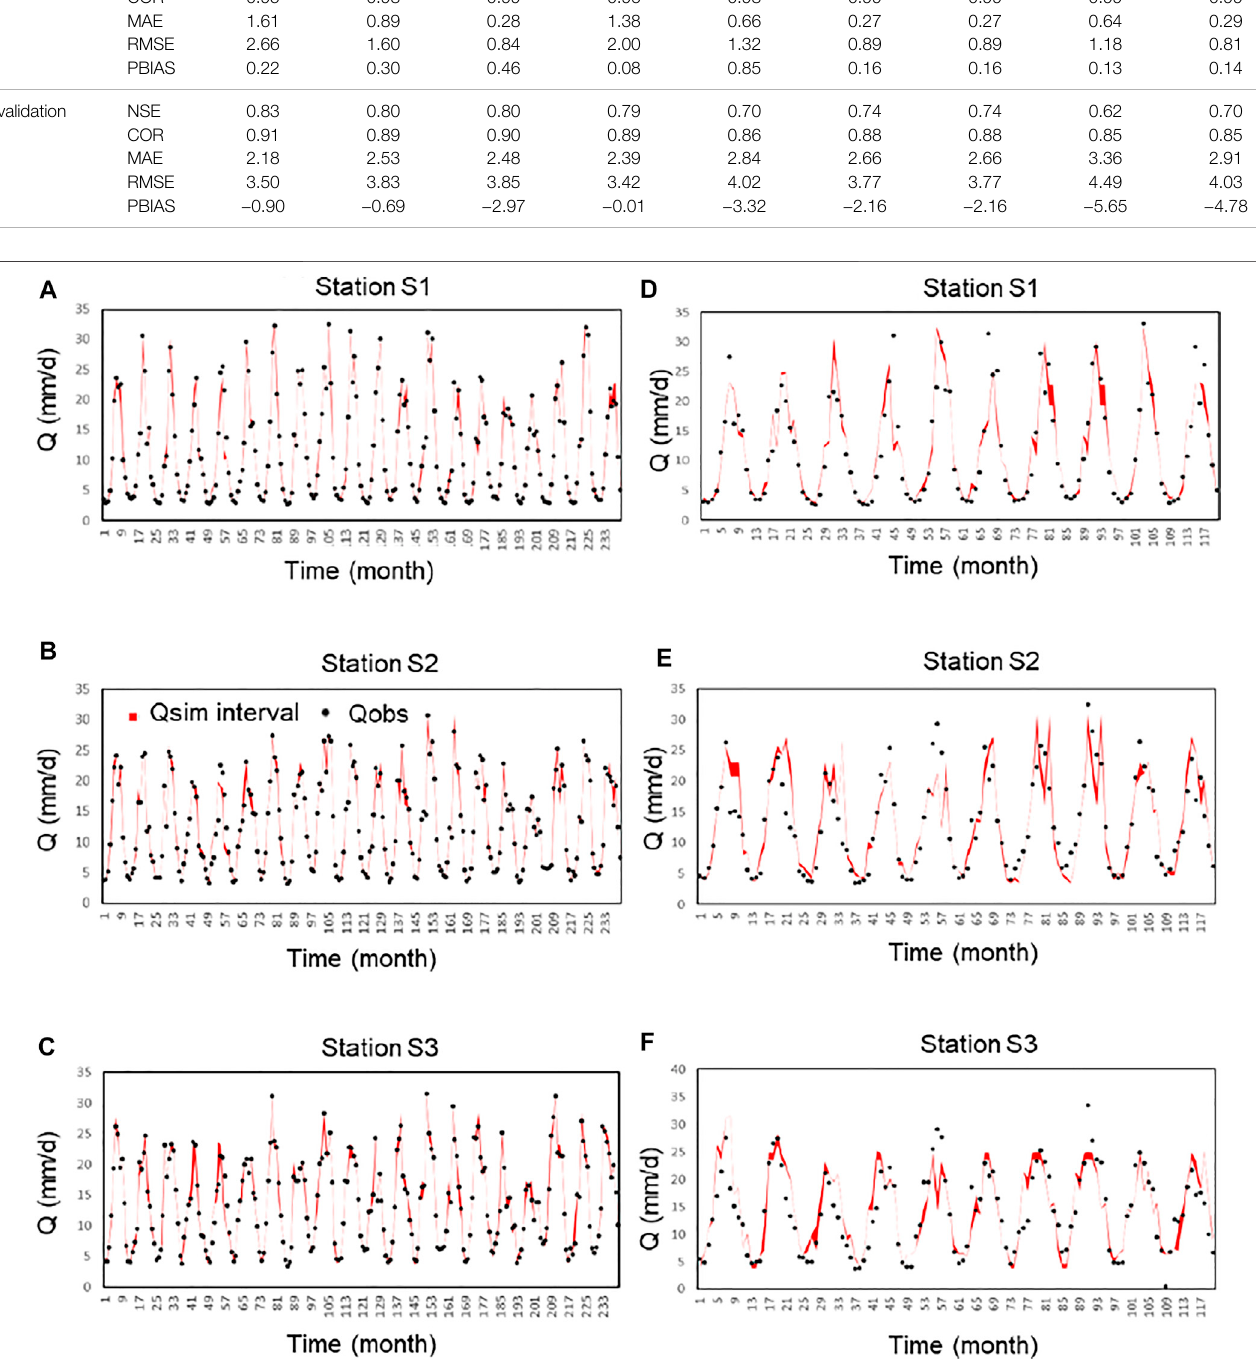
FIGURE6| Comparisonofforecastedintervalsversusobservedmonthly fl owusingSCAH(theredareas)withmeasurementvalues(theblackcircle)intheYangtze Riverwatershed. (Note:the fi rstcolumnpresentsthecalibration period andthesecondcolumnpresents thevalidationperiod.StationS1,S2,and S3representYichang station, Hankou station, and Datong station).